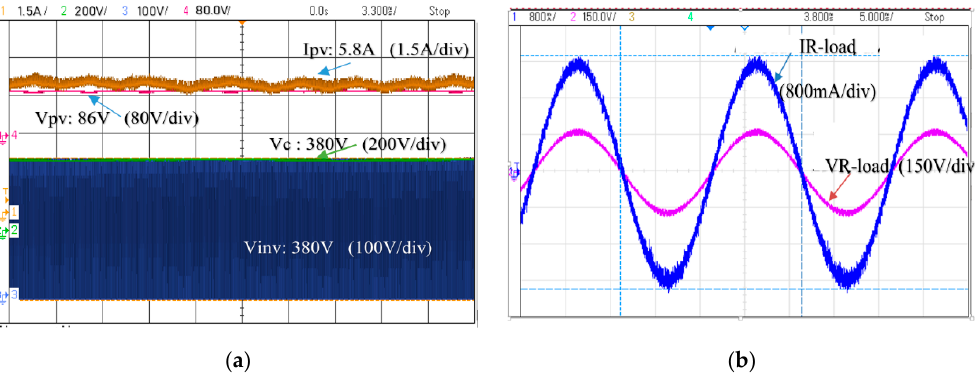
Figure 14. Experimental result for single-input operation: ( a ) PV current and voltage, the capacitor voltage V C , and the inverter voltage V inv , ( b ) the output current and voltage on the resistive load.